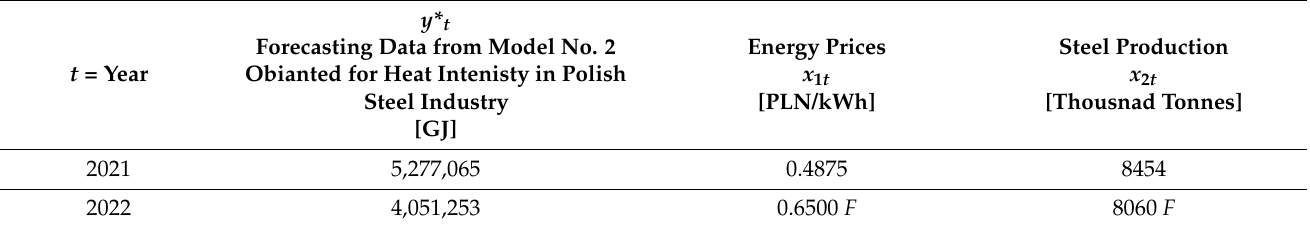
Table 8. Forecast of the heat intensity in the Polish steel industry based on model no.